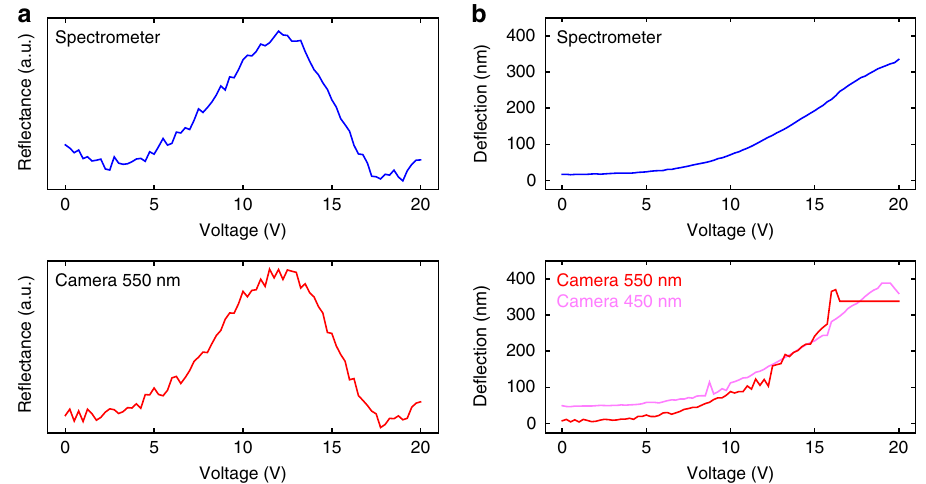
Fig. 2 Conversion from re fl ectance – voltage curves to de fl ection – voltage curves for λ = 550 nm. a The optical response in that selected wavelength from the spectrometer measurements (top panel) and color- fi ltered camera images (bottom panel) show the same trend. b By fi tting the re fl ectance curves with Eq. (1), we obtain the corresponding de fl ections as a function of applied voltage, which agree well for both types of measurements. A maximum de fl ection of 350 – 400 nm is obtained for this membrane (same device as in Fig.